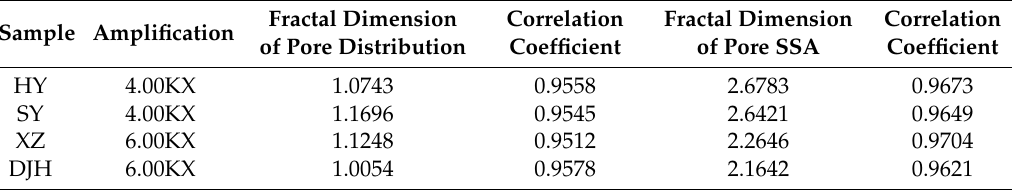
Table 7. Calculated fractal dimensions of